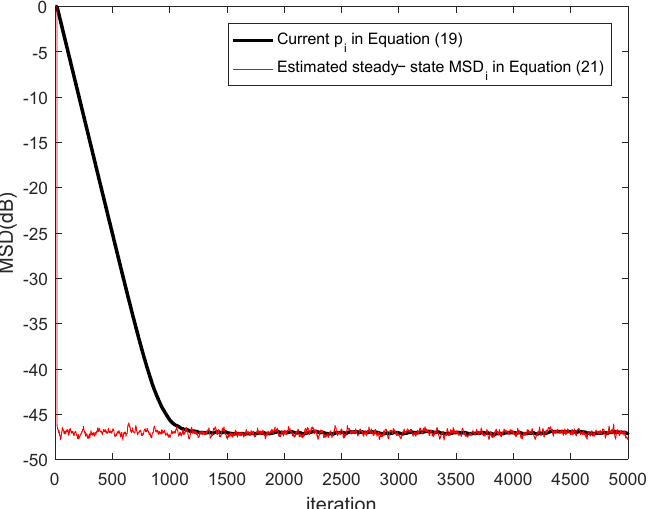
Figure 1. Convergence plots of the current p i and steady-state MSD values (SNR = 30 dB, M = 16, K = 8).